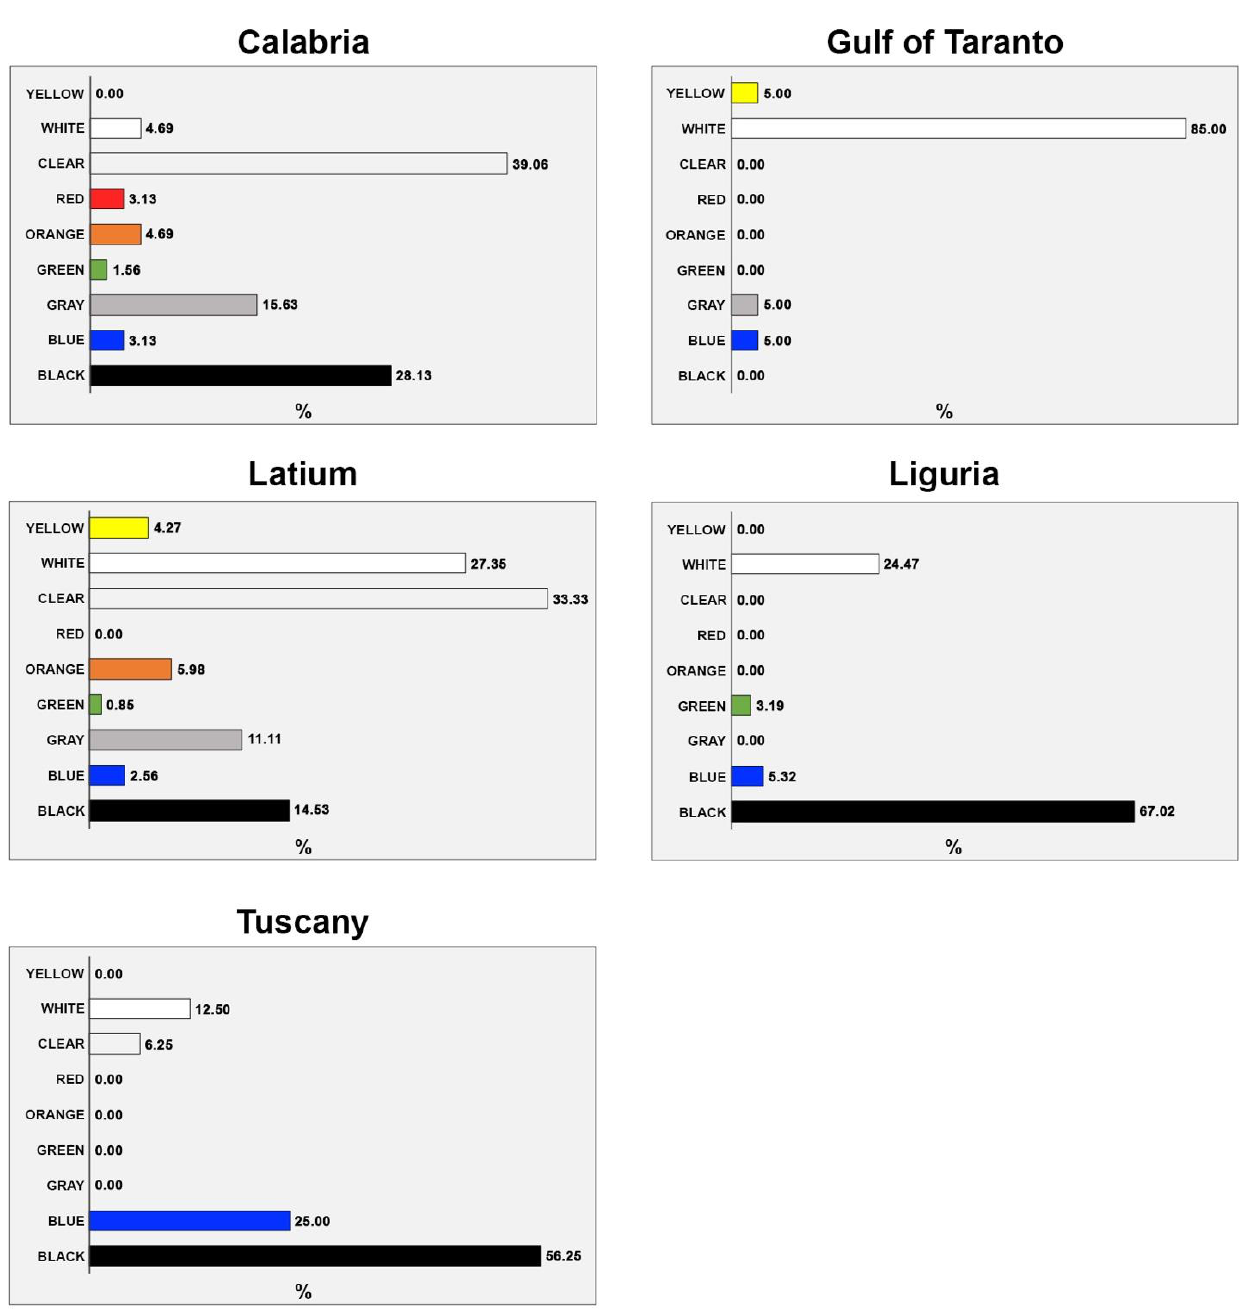
Figure 3. Frequency distribution by colour of plastic fragments found in the stomachs of blackmouth catsharks in the five populations studied. The colour of the bars corresponds to that of the plastics.